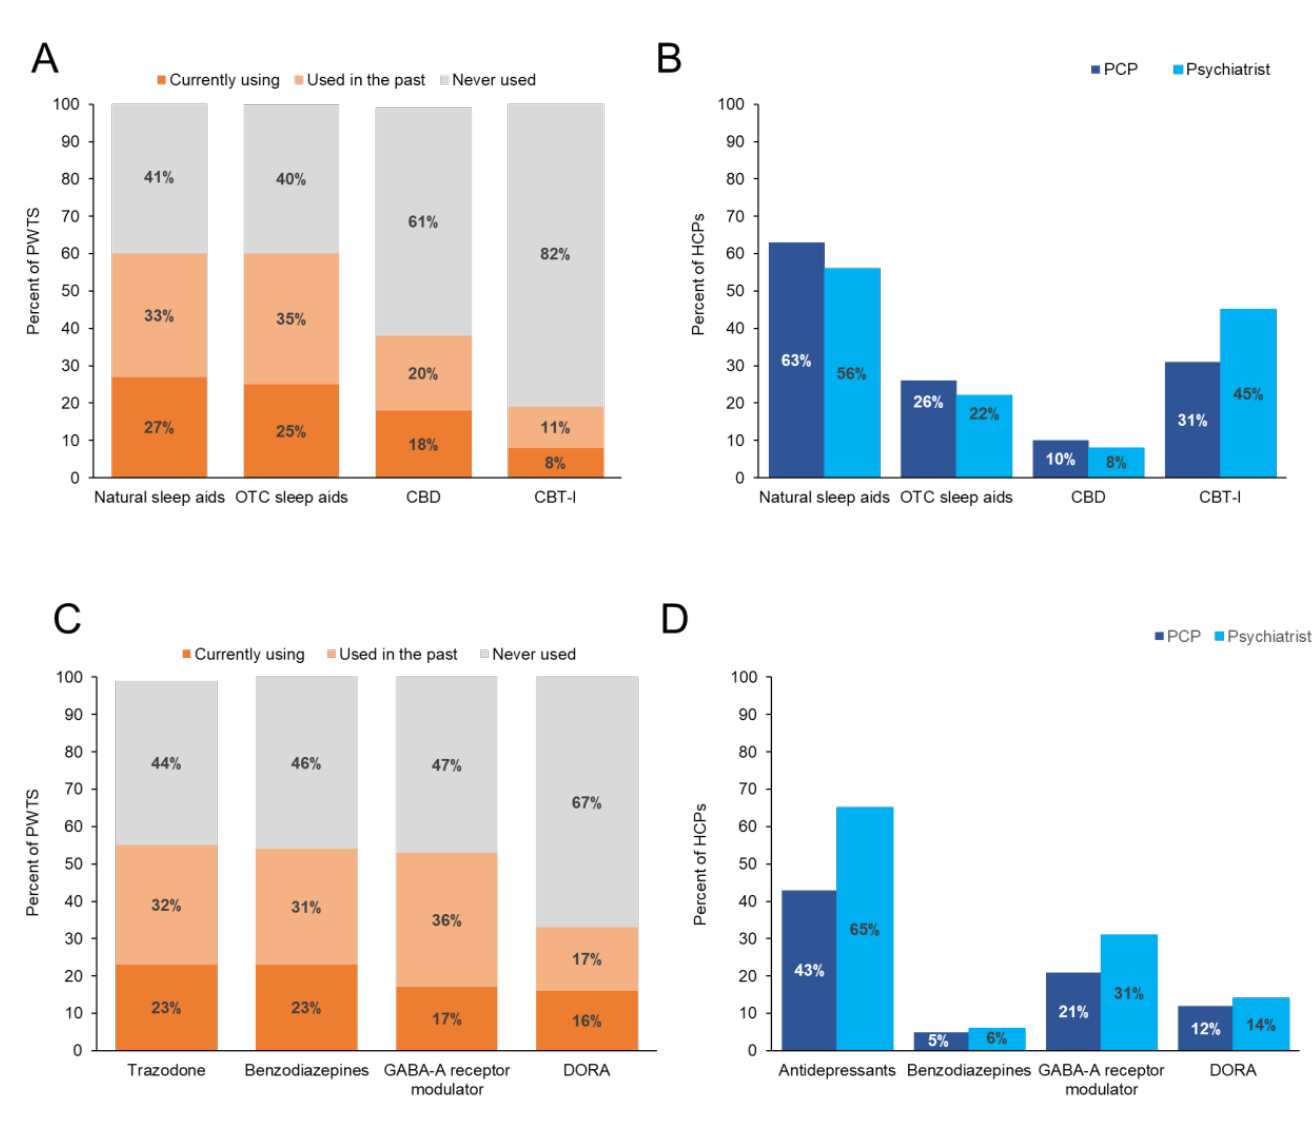
Figure 2. Use of prescription sleep medication and nonprescription treatment reported by PWTS and how often they are recommended by HCPs. ( A ) Use of natural sleep aids, OTC sleep aids, CBD, and CBT-I in PWTS who have ever used a prescription sleep medication and ( B ) percentage of PCPs/psychiatrists who always (or always)/often recommend nonprescription treatments. ( C ) Use of trazodone, benzodiazepines, GABA-A receptor modulators, and DORAs in PWTS who have ever used a prescription sleep medication and ( D ) the percentage of PCPs/psychiatrists who always (or always)/often prescribe treatments. Due to rounding completed by the Harris Poll, percentages may add up to more than 100%. CBD, cannabidiol; CBT-I, cognitive behavioral therapy for insomnia; DORA, dual orexin receptor antagonist; GABA-A, γ-aminobutyric acid type A; HCP, health care professional; OTC, over the counter; PCP, primary care physician; PWTS, people with trouble sleeping.